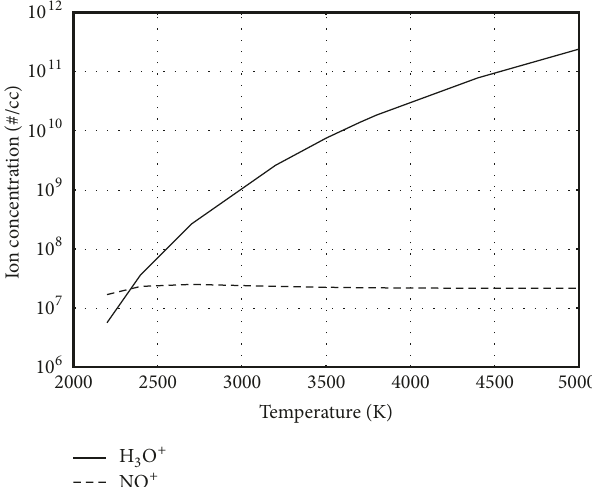
) on the concentration e Figure 4: Effect of gas temperature on NO + ion concentration for P = 1, 40 and 80 atm under conditions of thermal equilibrium (T T ) in a stoichiometric propane-air g